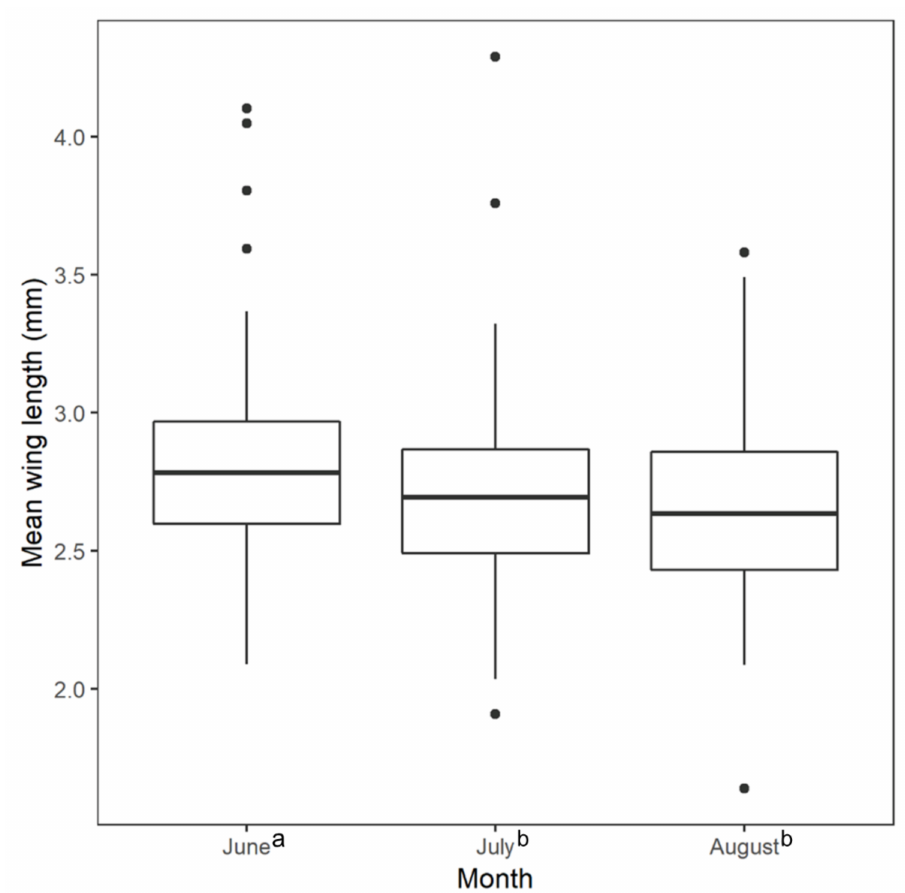
Figure 2. Mean female Aedes albopictus wing length by collection month. The mean June wing length was longer than the July and August mean wing lengths. There was no significant difference between the July and August mean wing length. Superscript lowercase letters indicate values significantly different from one another in the Kruskal–Wallis tests with a post-hoc Wilcoxon rank sum test at p ≤